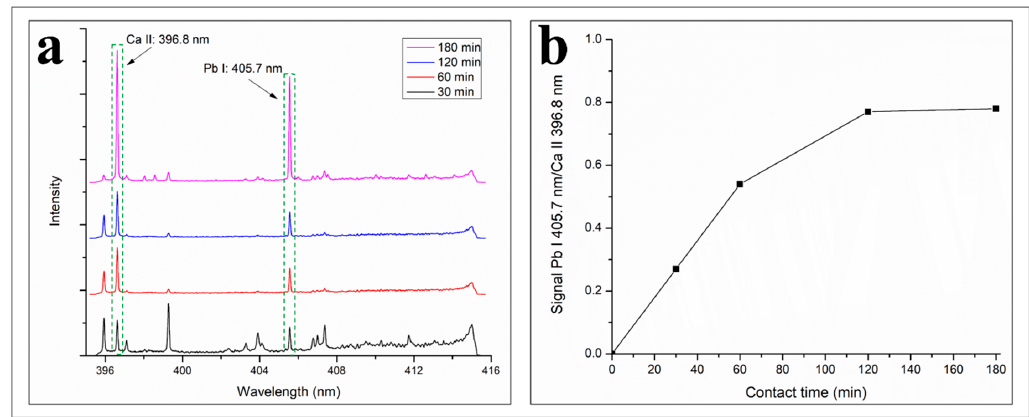
Figure 9. ( a ) LIBS spectra of B/COPUF after the adsorption of Pb 2+ with a variation of contact time and ( b ) the Pb I/Ca II signal peak ratio.